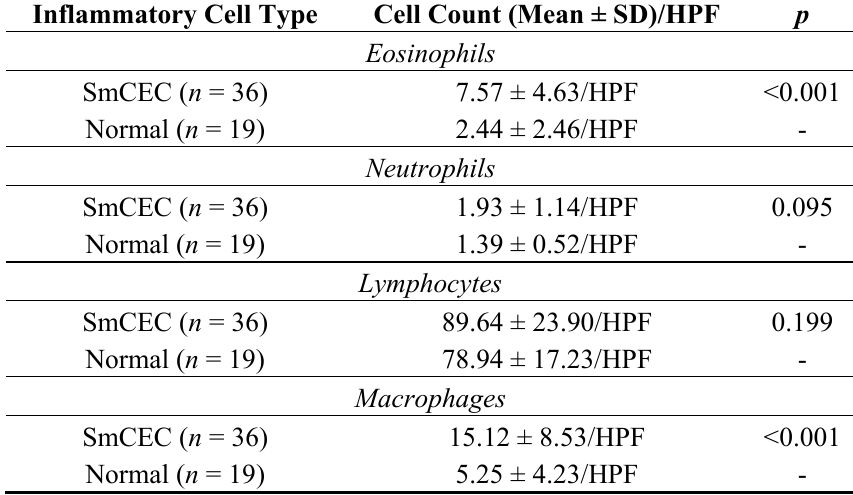
Table 1. Inflammatory-cell infiltration in SmCEC (small cell esophageal carcinoma) and in tumor-adjacent normal tissues.